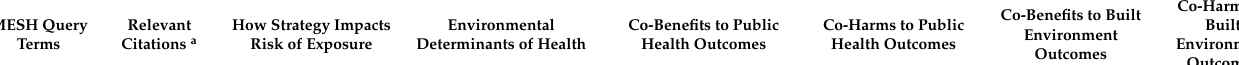
Table A1. Association between LEED Credits and community resilience to extreme heat events: a review of the evidence. LEED